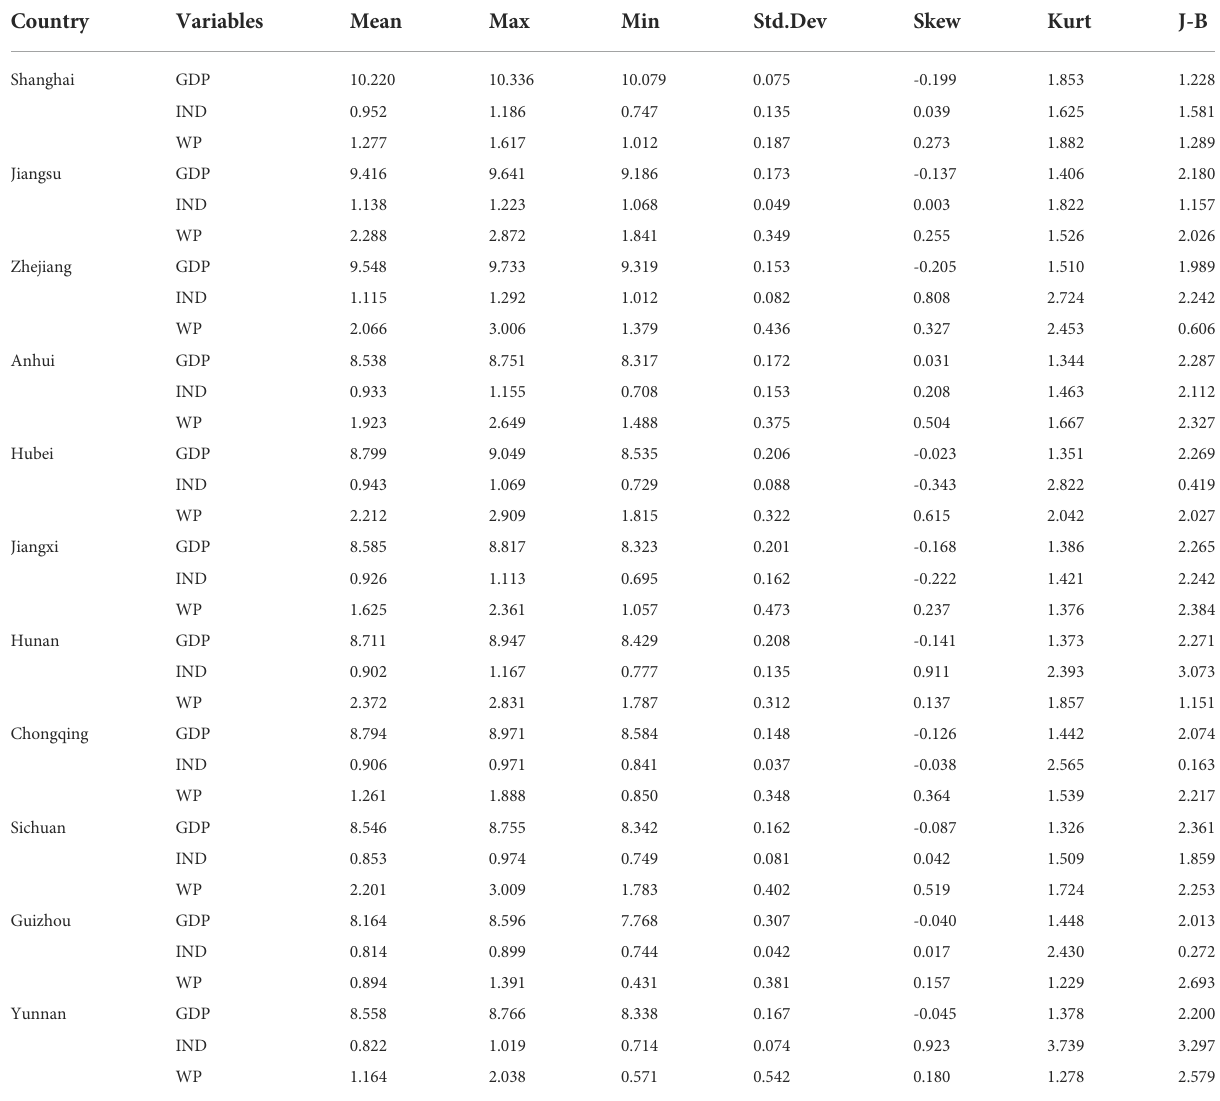
TABLE 1 Summary